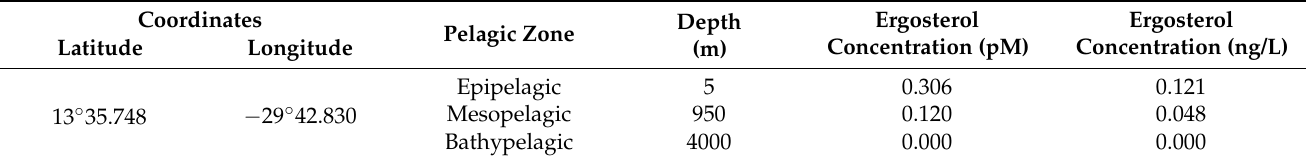
Table 1. Ergosterol content in the seawater of the Atlantic Ocean obtained with the chloroform-methanol approach (Bligh and Dyer 1959) .